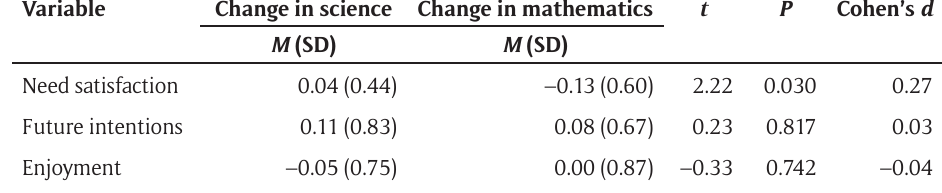
Table 1: Comparison of changes in the mean values of each measurement instrument between the science and math- ematics measures.